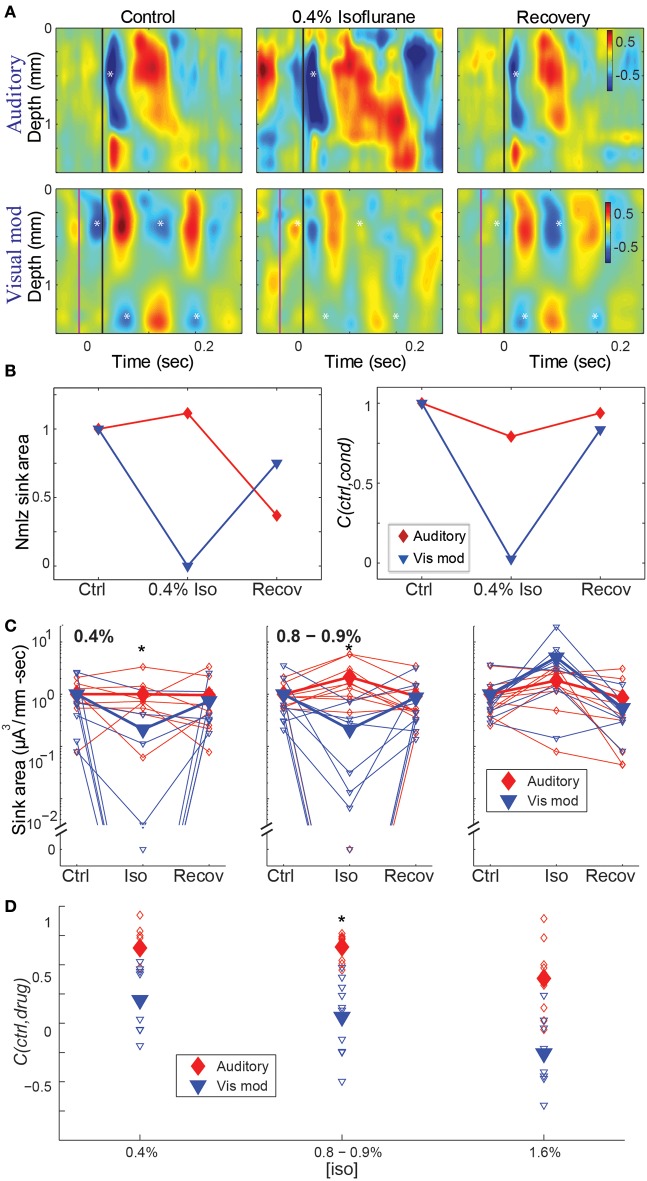
Effect of isoflurane on spatiotemporal activity patterns in auditory cortex. (A) CSD profiles of responses recorded in one animal to an auditory stimulus (50 ms tone, 17.4 kHz, 40 dB SPL) alone (top) and visual modulation of the auditory response (bottom) recorded in room air (left), 0.4% isoflurane (center) and recovery (right). Note early auditory response component (asterisk) that is relatively unaffected by isoflurane, and alternating supra- and infragranular sinks during visual modulation response (asterisks) that are suppressed by isoflurane. In center and right panels, asterisks are plotted at the same relative positions as in left panel. (B) Normalized response magnitude (left; normalized to the average of the control values) and correlation coefficient between control and drug and recovery responses (C(ctrl,cond)) for the data in (A) (red: auditory; blue: visual modulation). (C–D) Summary across animals. Magnitude (C) and correlation coefficient (D) of the auditory (red) and visual modulation (blue) responses under different isoflurane concentrations. Open symbols: single animals; filled symbols: average across animals. *p < 0.05, repeated measures ANOVA, in (C) and p < 0.017, paired Student's t-test, in (D).